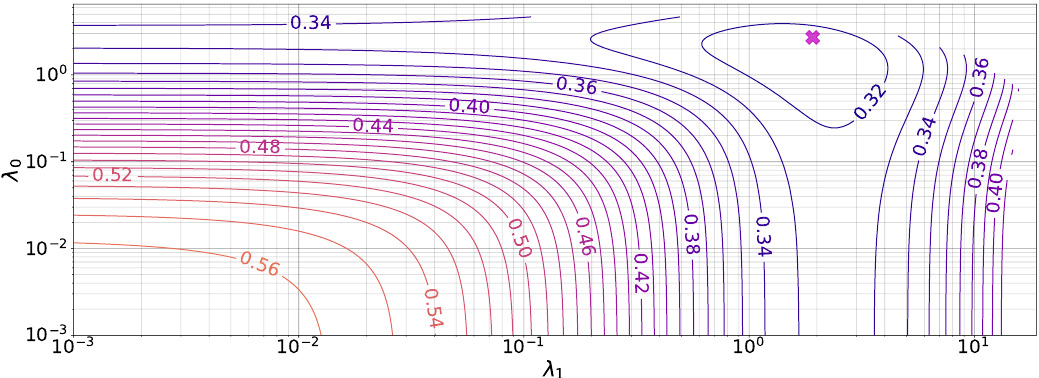
Figure 3: Absolute Monte Carlo integration error for the first sector of the ladder2L example, depending on λ (cid:126)λ = ( 2.71,1.91,2.73,0.46,5.91,1.59 ) (marked with a cross), which is the op- timum point selected by Λ -glob. Note that integration error only varies between 0.32 and 0.56 over 3 orders of magnitude in λ